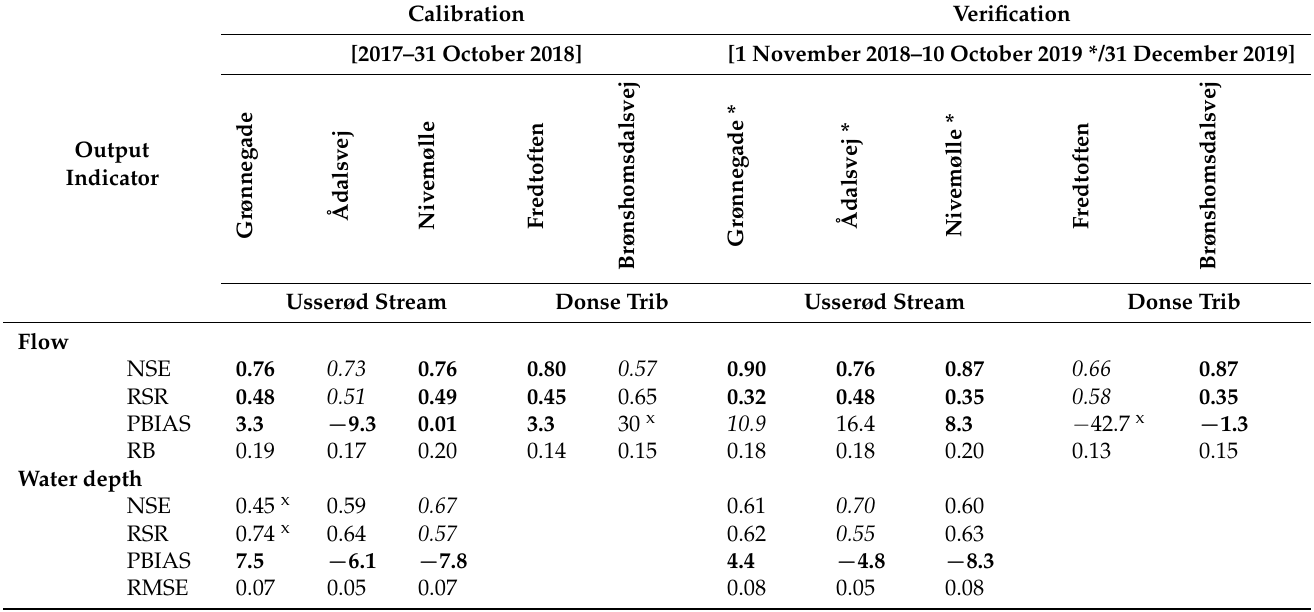
Table 1. Performance indicators for flow and depth simulations, including the Nash-Sutcliffe Efficiency (NSE), Percent BIAS (PBIAS), RMSE-observations standard deviation ratio (RSR), and Flashiness index (RB, flow only) for all reaches, for both the calibration and verification period. Performance rating values for all indicators, except RB are indicated as follows [78]: very good (in bold); good (in italic); satisfactory; unsatisfactory (marked with an x). Additional simulation results can be found in Figures